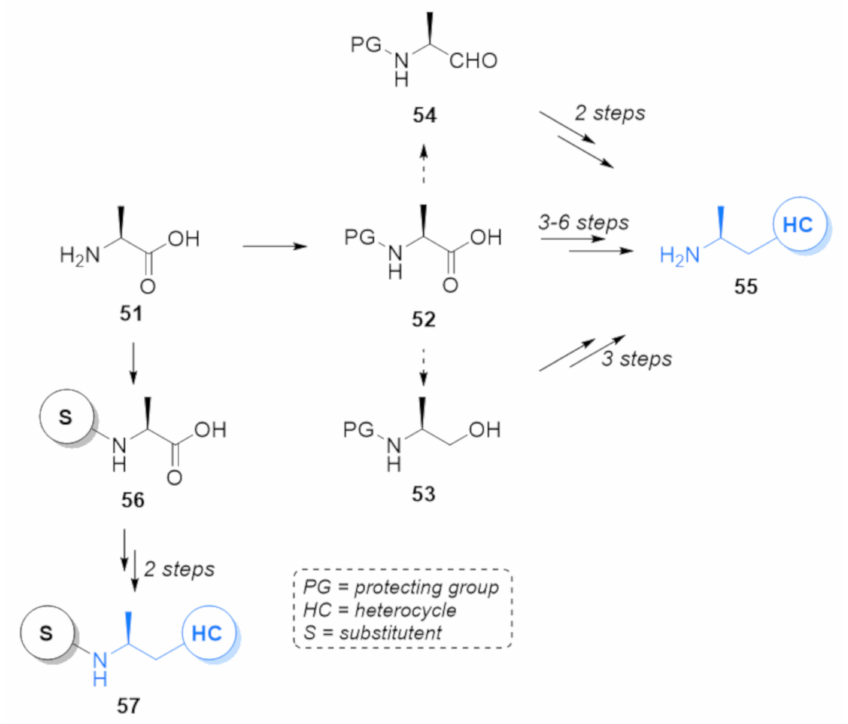
Figure 11. “Traditional” chemical synthesis of chiral 3D heterocycle-containing